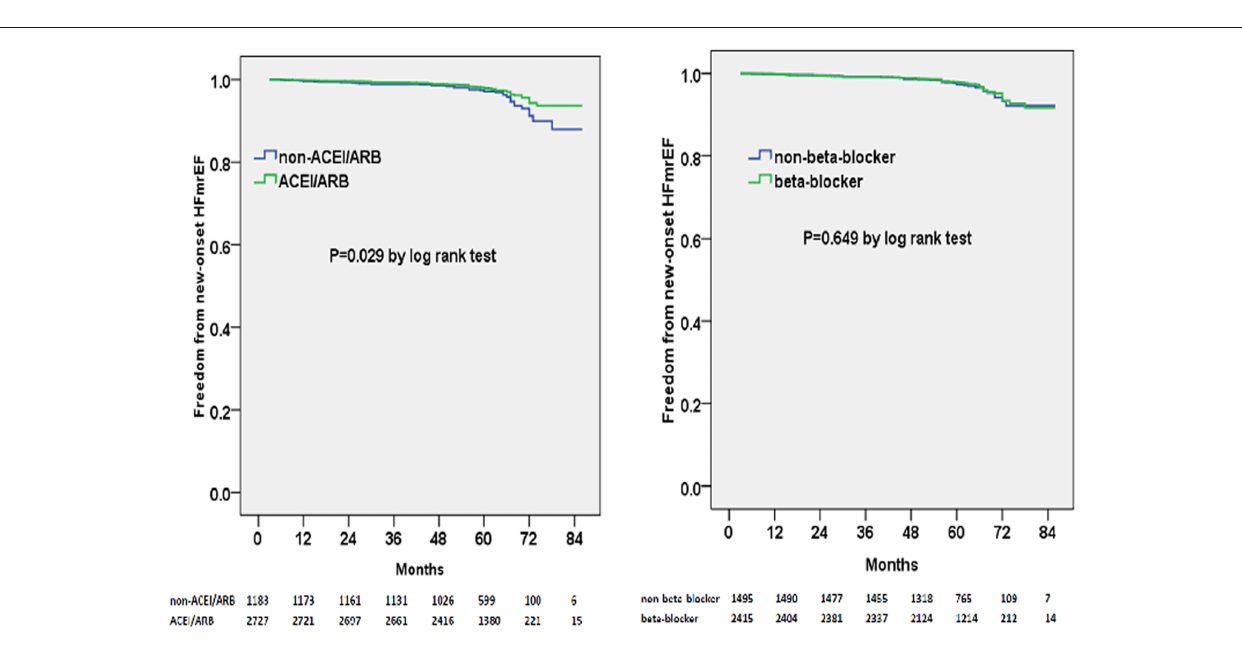
the prevalence of HF continues to rise, among which HFpEF has become the predominant type (16). Although the progress of pharmacologic and non-pharmacologic therapies in recent years have improved the clinical outcome of HF, they are